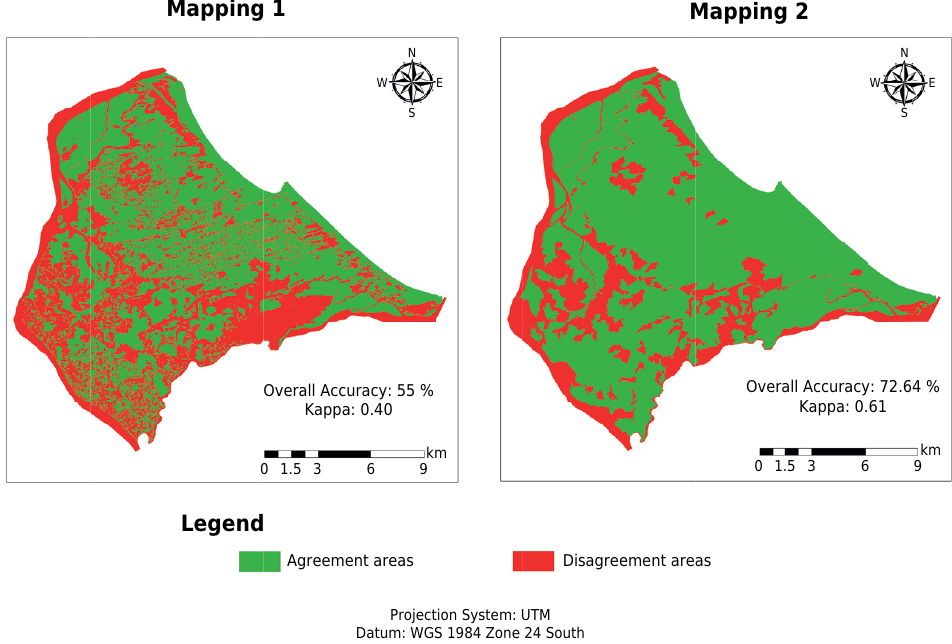
Figure 8. Analysis of agreement between the pre-existing soil map and the digital